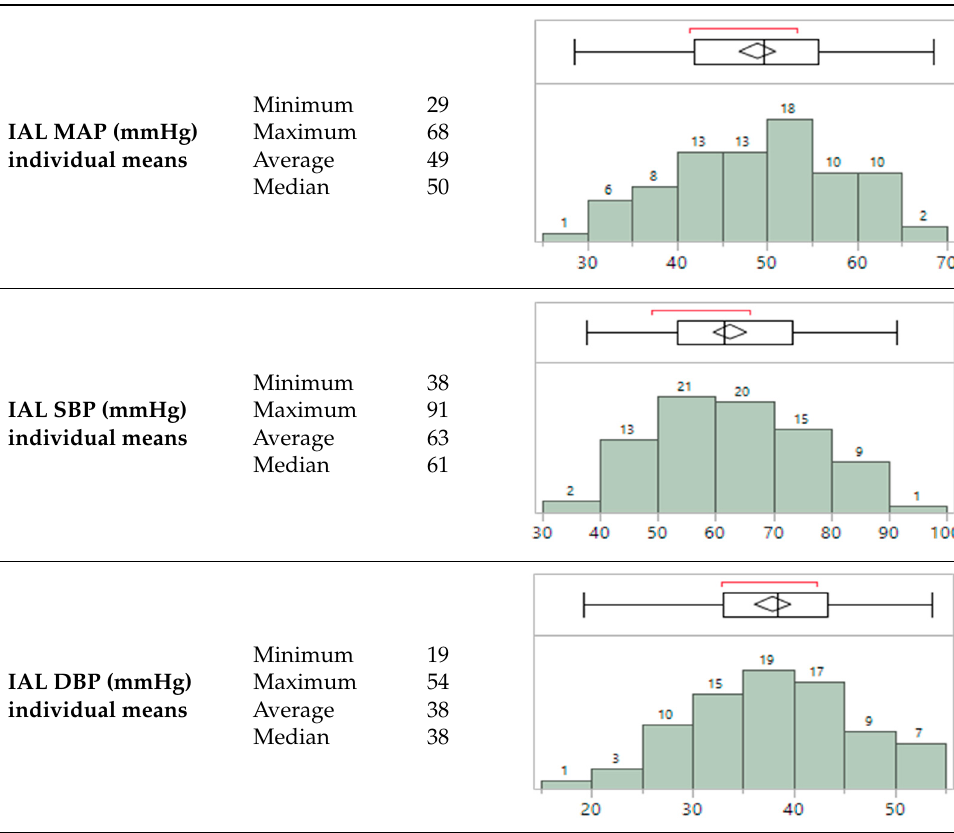
Table 5. Characteristics of the IAL and Boppli placement locations.